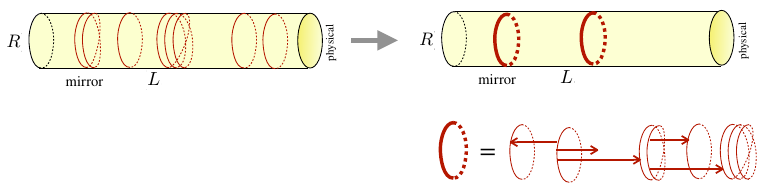
Figure 4 . Wrapping particles put in a large box of length L form a non-ideal gas with interaction (cid:24) 1 =L . The free energy is a sum over non-interacting clusters of wrapping particles. The perturbative series of the expectation value (3.17) gives the exact cluster expansion to all